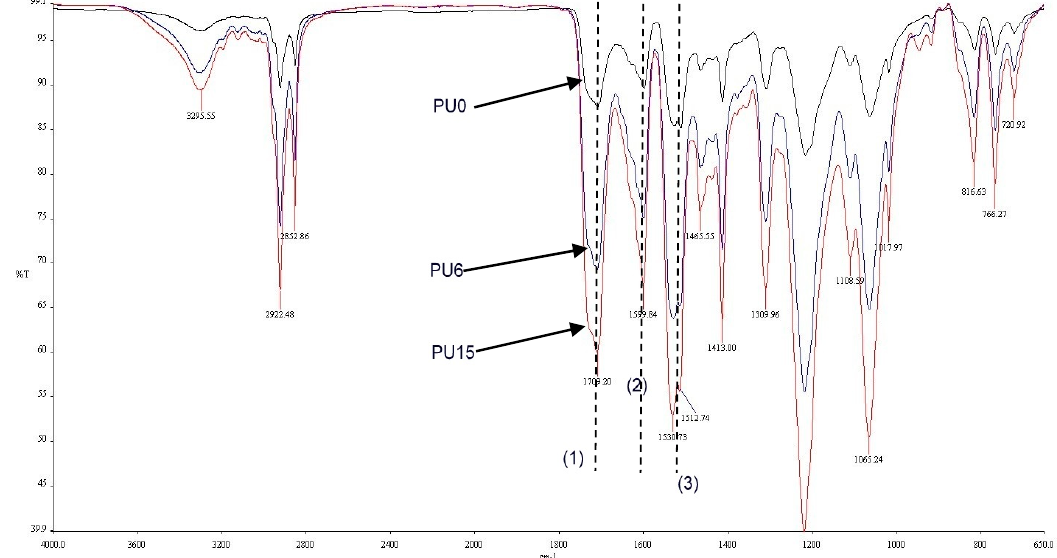
Figure 4. FT-IR spectrums of the PUs (PU0, PU6 and PU15 are types of PU and PU6—PU which contained 6% PEG).